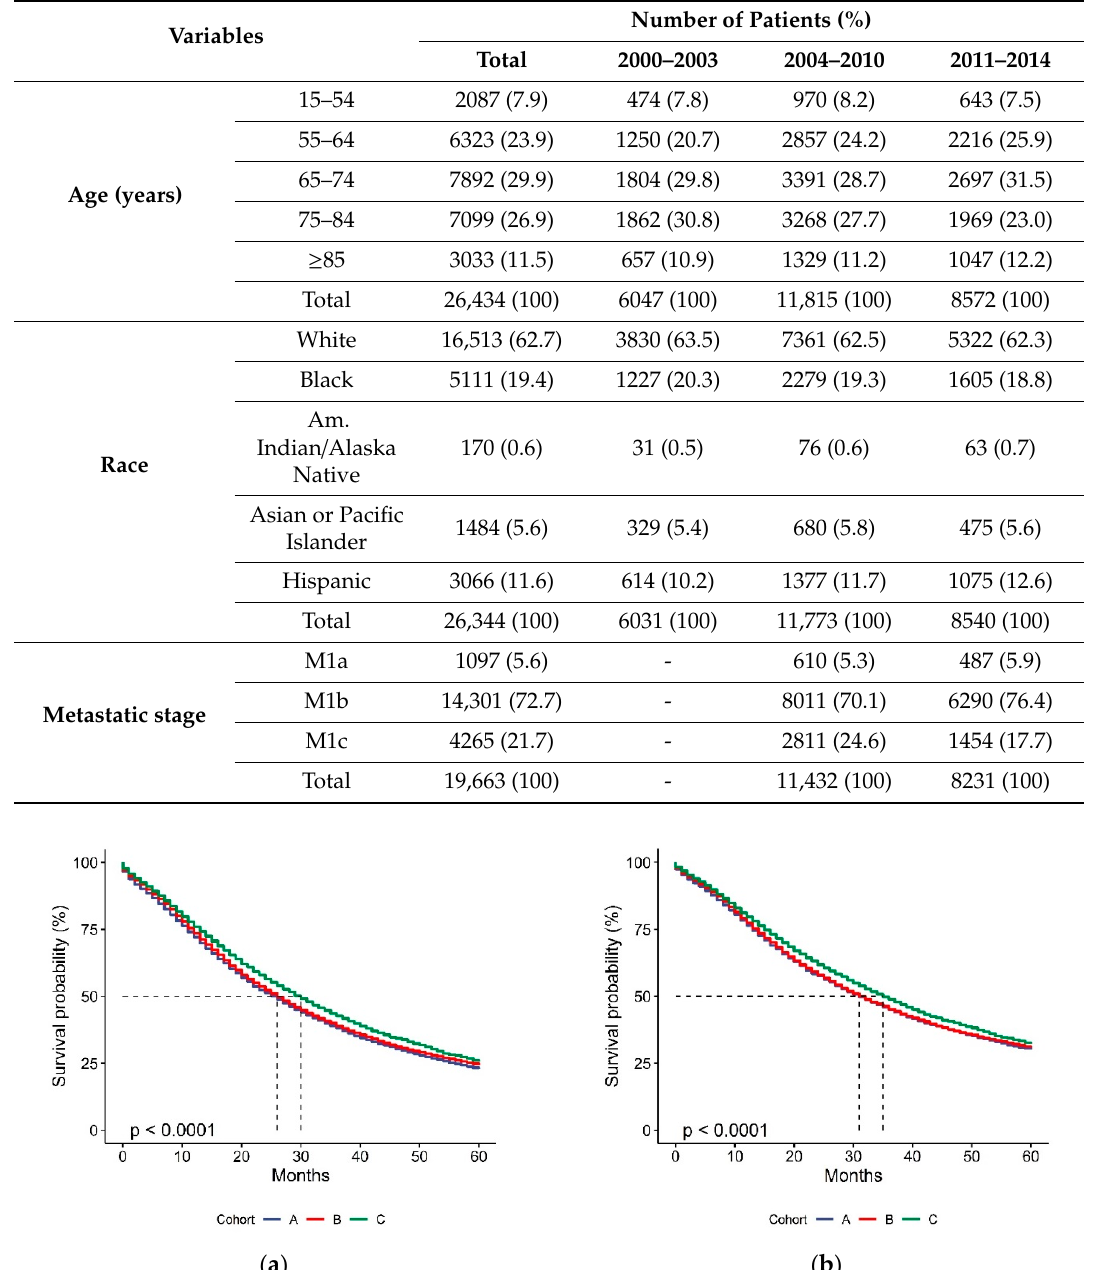
Table 1. Basal characteristics of patients.